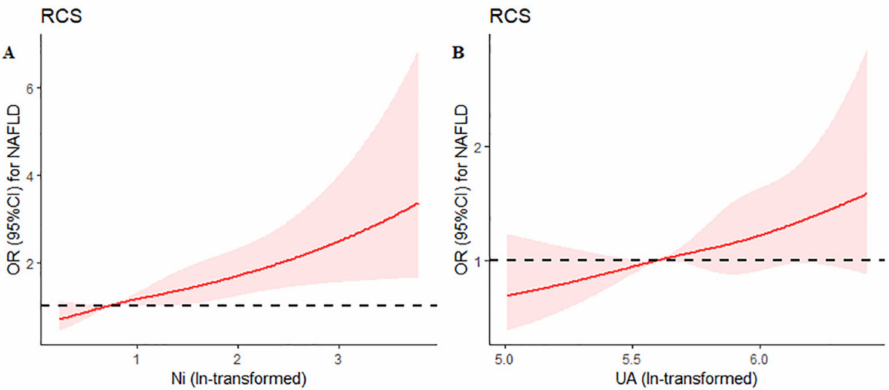
Figure 4. Restricted cubic spline analysis representing the associations between serum Ni ( A ) and UA ( B ) with NAFLD. Serum uric acid and nickel concentrations (ln-transformed, X -axis) and non- alcoholic fatty liver disease ( Y -axis) were fitted by restricted cubic spline models with four knots at the 35th, 65th, and 95th percentiles of its distribution; the reference value (odds ratio = 1) was set at the 5th percentile. The red line represents the dose relationship between serum nickel ( A ) or serum uric acid ( B ) with the risk of NAFLD after logarithmic transformation. The black dotted line indicates odds ratio is 1, and the pink area indicates the confidence interval. Adjusted variables: age, sex, BMI SBP, DBP, AST, TBIL, ALP, TC, TG, LDL-C, HDL-C, fasting glucose, HbA 1C